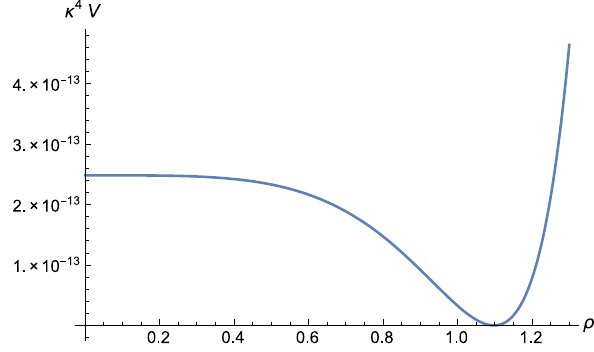
Fig. 2 This plot shows the scalar potential for F = 0, b = 3 / 2, ξ = −